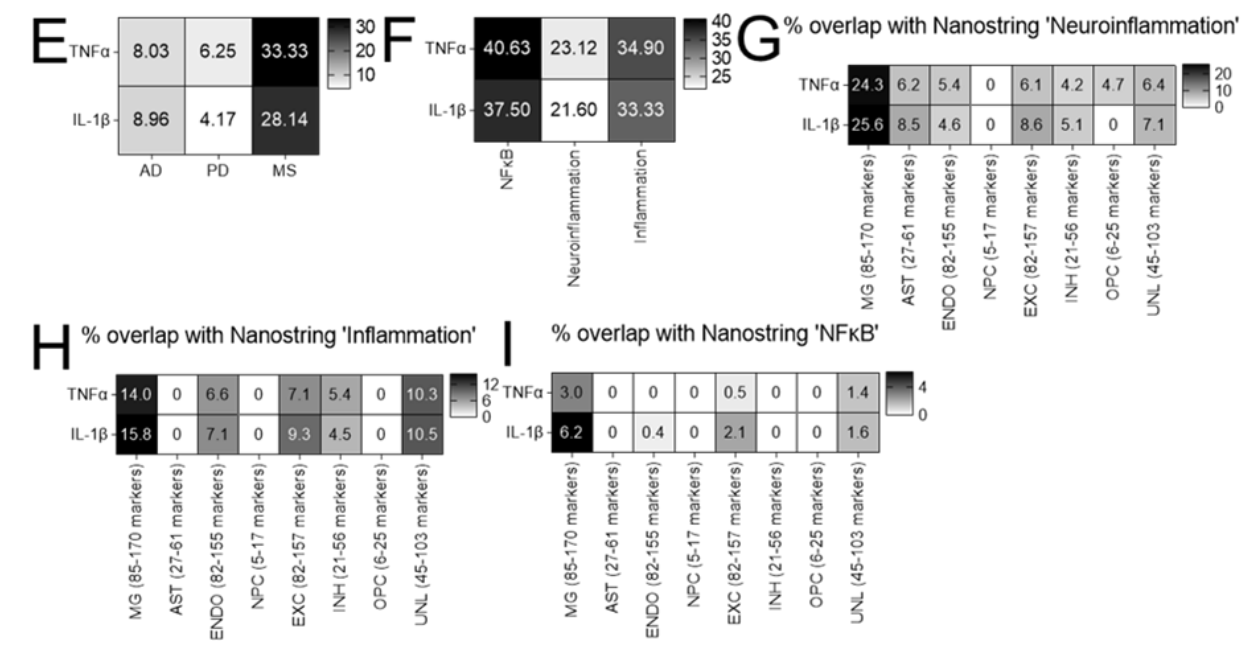
Figure 6. Differentially expressed genes (DEGs) in human cortical spheroids (hCSs) stimu- lated with TNF α or IL-1 β are mainly expressed in endothelial cells, microglia and astrocytes. ( A , B ) Percentage of overlap between DEGs in hCSs stimulated for 4 h, 12 h and 36 h with ( A ) TNF α or ( B ) IL-1 β and cell-type marker genes derived from [25], based on a cut-off of >10-fold expression difference with the other cell types; percentage of overlap was averaged over marker genes from five human brain regions. ( C – F ) Percentage of overlap between DEGs in hCSs stimulated for 4 h, 12 h and 36 h with TNF α or IL-1 β and ( C ) DEGs in a human fetal microglia cell line (HMC3) or a human adult oligodendroglioma cell line (HOG) stimulated with pro-inflammatory factors (LPS for 24 h and subsequently TNF α and IL-1 β for 24 h (LPS + T + I)), ( D ) cell-type marker genes for Alzheimer’s disease (AD), Parkinson’s disease (PD) and multiple sclerosis (MS) (cell-type marker genes derived from [26]), ( E ) genes associated with AD, PD and MS as derived from the Nanos- tring project, ( F ) NF κ B-, neuroinflammation- and inflammation-associated genes as derived from the Nanostring project. ( G ) Percentage of overlap between DEGs in TNF α - or IL-1 β -stimulated hCSs that are cell-type marker genes (derived from [25]), and neuroinflammation-associated genes, ( H ) inflammation-associated genes, or ( I ) NF κ B-associated genes derived from the Nanostring project. MG: microglia; AST: astrocyte; ENDO: endothelial cell; OPC: oligodendrocyte precursor cell; NPC: neural progenitor cell; IN: inhibitory neuron; EXC: excitatory neuron; UNL: other, unlabeled cell